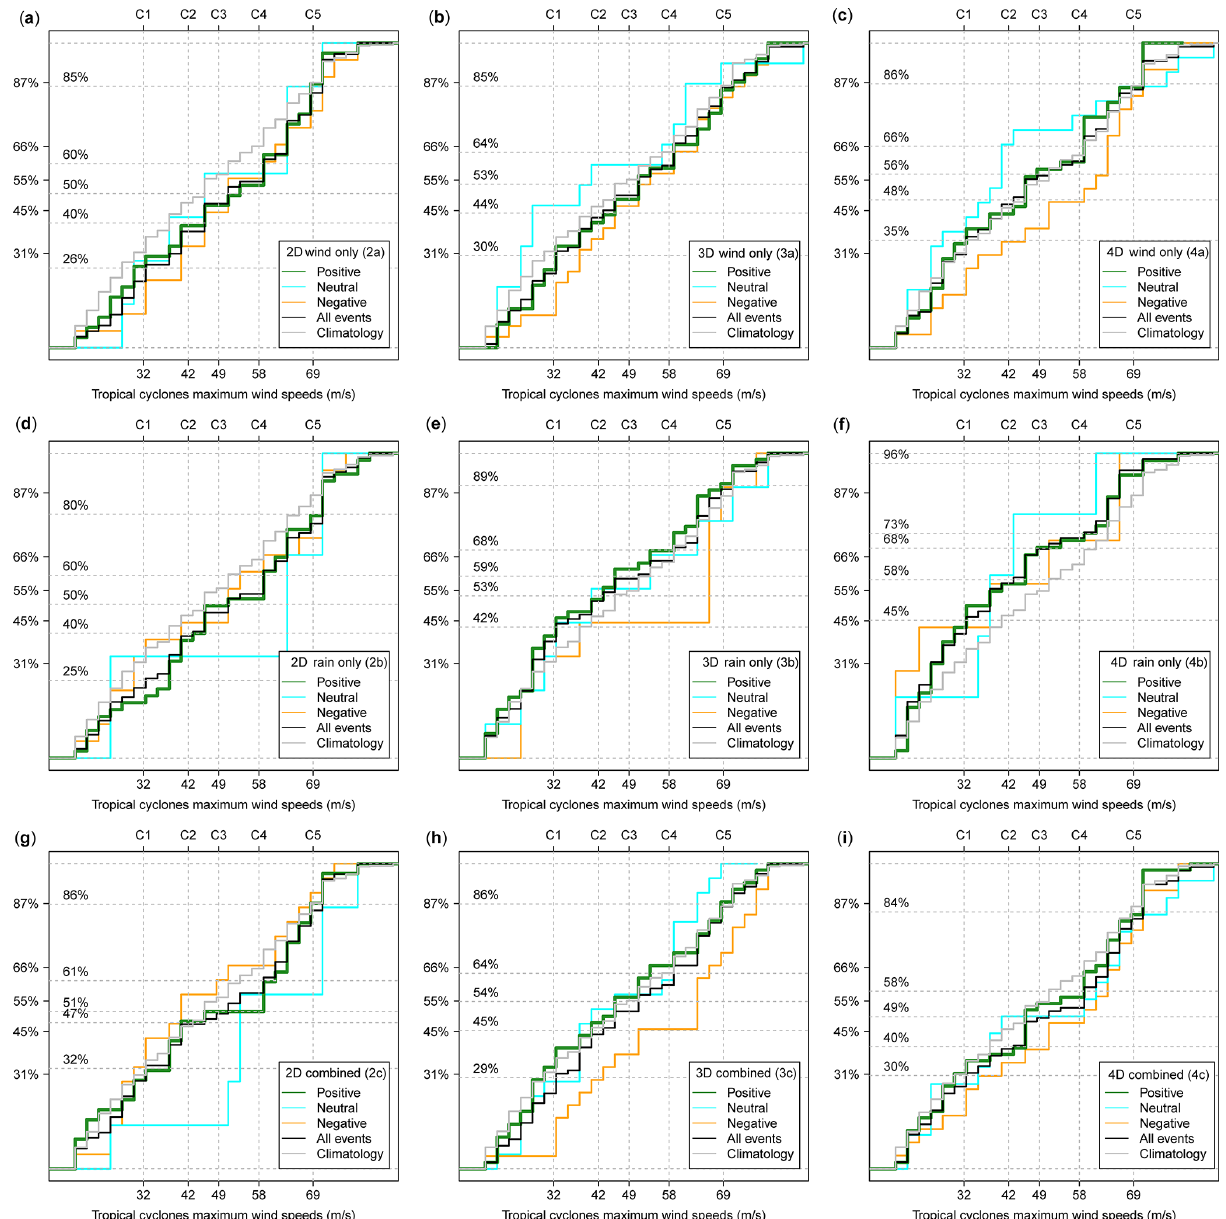
Figure A3. Cumulative distribution of tropical cyclones as a function of their maximum intensity for the nine definitions of affected area used in this study. The cumulative distribution for the census of 580 tropical cyclones recorded for the study period is shown left of the y axis for class I (31%), class II (45%), class III (55%), class IV (66%), and class V (87%) cyclones. The numbers shown on the right of the y axis represent the cumulative distribution of the sample of the 580 events following a specific definition. Panel (a) shows wind only for two diameters, (b) wind only for three diameters, (c) wind only for four diameters, (d) rain only for two diameters, (e) rain only for three diameters, (f) rain only for four diameters, (g) wind or rain for two diameters, (h) wind or rain for three diameters, and (i) wind or rain for four diameters as detailed in Table A1. The intensity distribution for tropical cyclones with a negative effect size is shown in orange, for tropical cyclones with a neutral effect size in blue, and for tropical cyclones with a positive effect size in green. The black solid line shows the distribution for the specific definition ( n = 140 ± 41 cyclones depending on the definition). The gray solid line shows the distribution of the 580 events that occurred between 1999 to 2018. Small deviations between the gray and the black line suggest that the sample represented the 580 cyclones well in terms of their intensity class. The maximum wind speed of category I cyclones is between 32 and 42ms − 1 , between 42 and 49ms − 1 for category II, between 49 and 58ms − 1 for category III, between 58 and 69ms − 1 for category IV, and exceeding 69ms − 1 for category V. In East Asia, tropical cyclones of intensity class III or higher are called